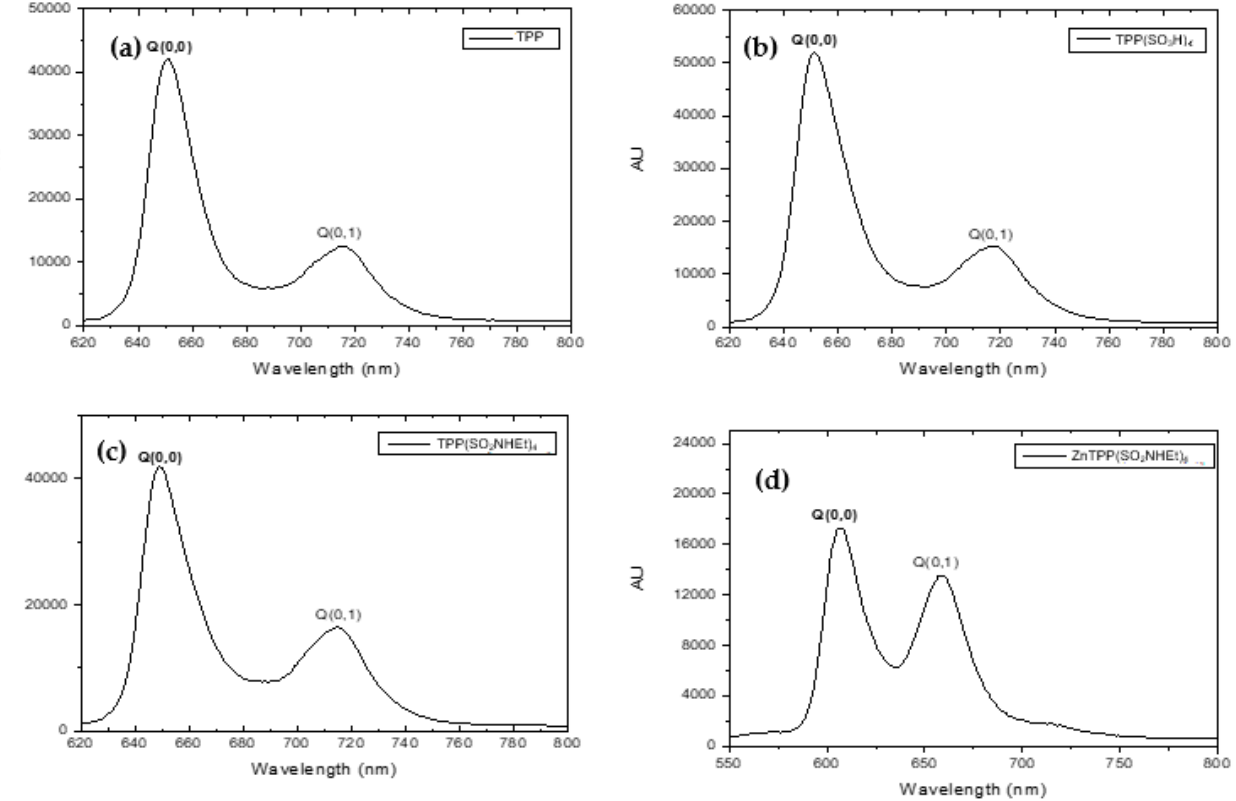
Figure 2. Fluorescence emission spectra and assignment of fluorescence emission bands: ( a ) TPP , ( b ) TPP(SO 3 H) 4 , ( c ) TPP(SO 2 NHEt) 4 , and ( d ) ZnTPP(SO 2 NHEt) 4 in DMF at 20 °C.